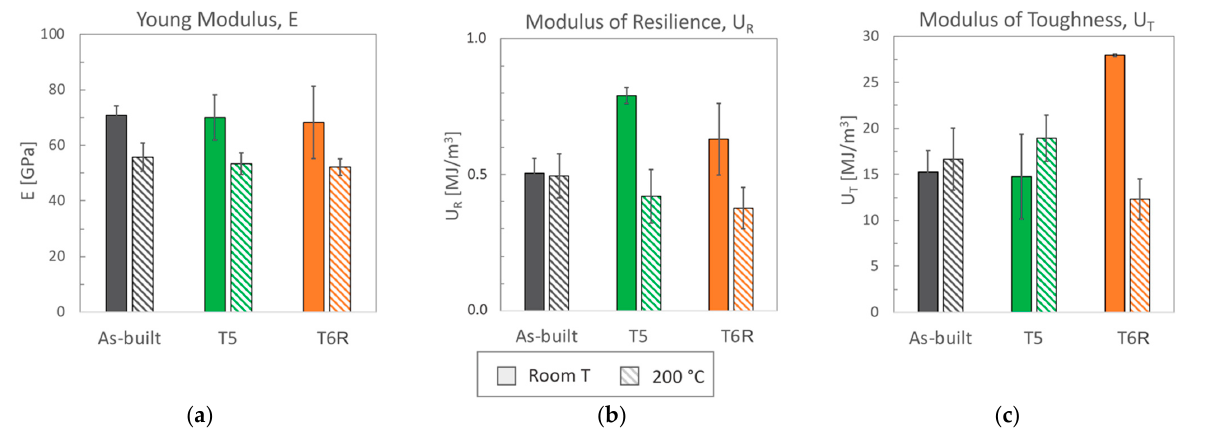
Figure 5. ( a ) Young, ( b ) resilience, and ( c ) toughness modulus (mean value and standard deviation) obtained from tensile tests performed at room and high (200 °C) temperature for the as-built, T5, and T6R AlSi7Mg PBF-LB alloy.